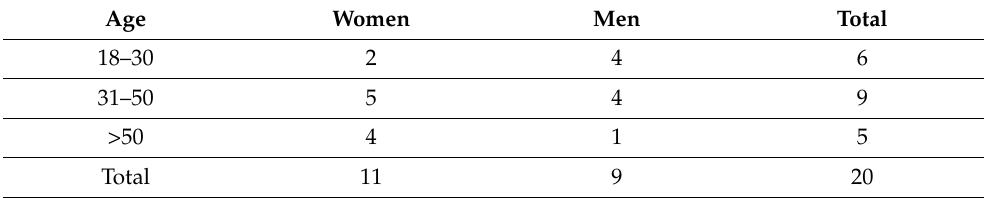
Table 1. Participants according to age and